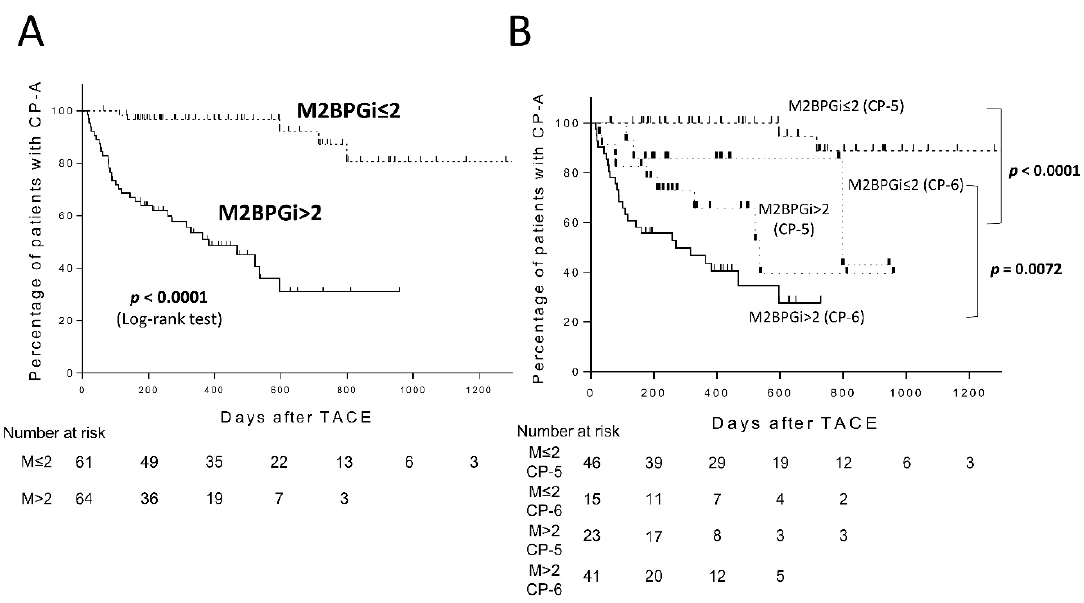
Figure 4. Child-Pugh grade deterioration from A to B after transarterial chemoembolization (TACE) in patients with Child-Pugh grade A (CP-A) according to Mac-2 binding protein glycosylation isomer (M2BPGi) levels and within or beyond the up-to-seven criteria.